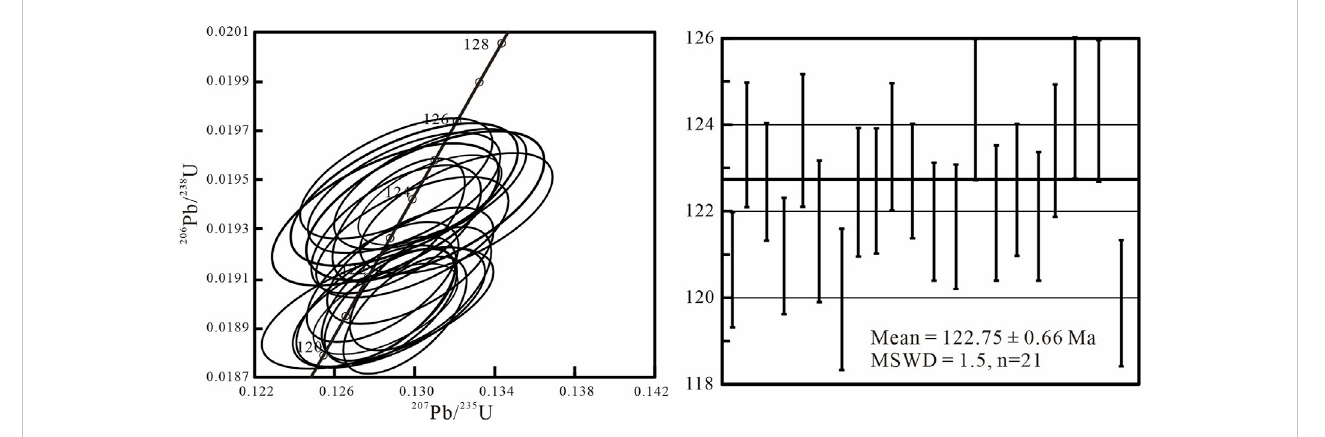
FIGURE 12 Zircon U-Pb Concordia diagram for the quartz diorite porphyrite dyke